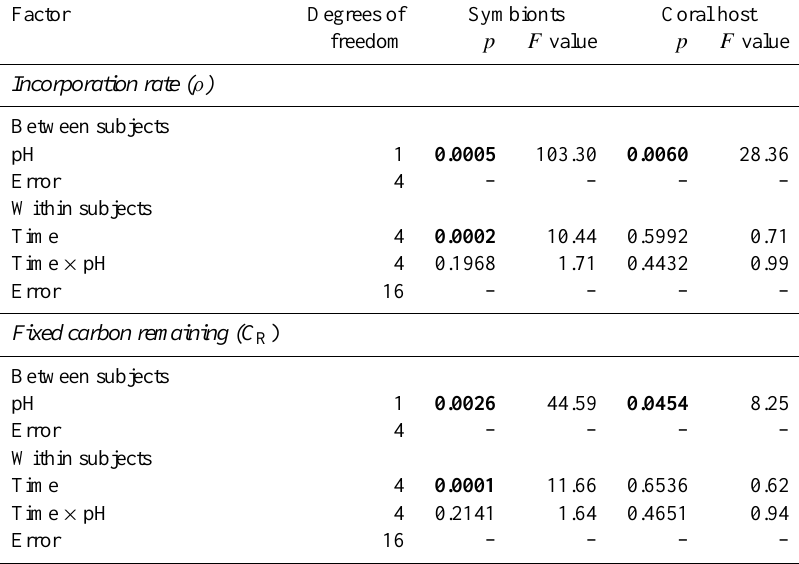
Table 3. Results of the repeated measures analysis of variance (ANOVA) testing the effect of pH and incubation time on the carbon incorpo- ration rates ( ρ ) and percentage of fixed carbon ( C R ) in the symbionts and coral host. Significant p values are in bold.